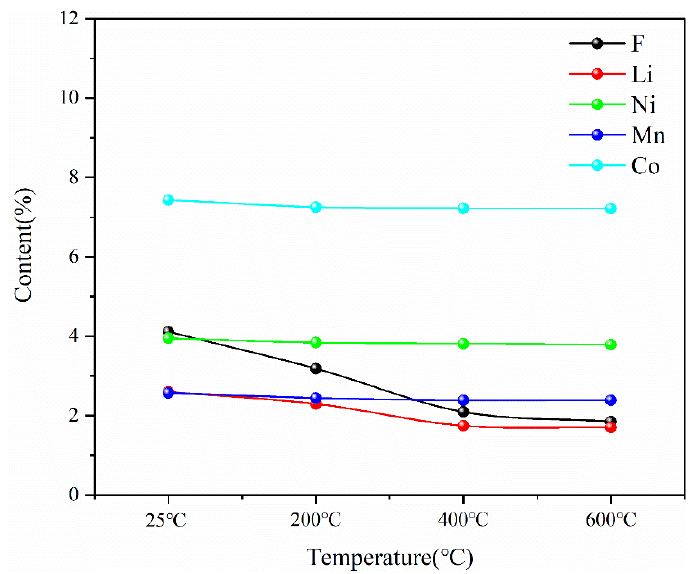
Figure 18. Contents of main elements in battery materials after pyrolysis at different temperatures.